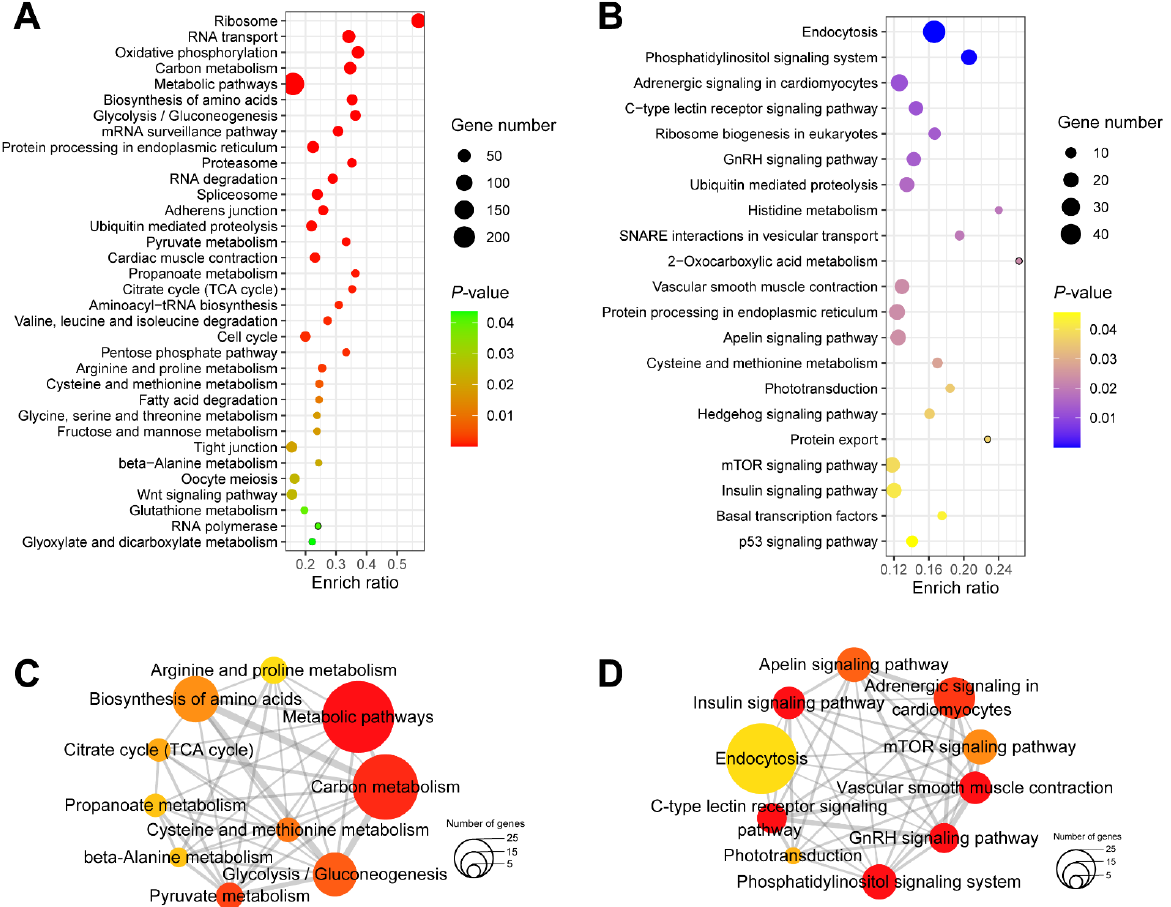
Figure 4. Hub signaling pathways from KEGG enrichment analysis of up- and down-regulated key genes. ( A ) Dot plot of KEGG signaling pathways for up-regulated key genes. ( B ) Dot plot of KEGG signaling pathways of down-regulated key genes. ( C ) Network of top 10 hub pathways for up-regulated key genes. ( D ) Network of top 10 hub pathways for down-regulated key genes. Nodes represent pathways and edges represent Jaccard similarity coefficients. Node color and size stand for the enrichment p -value and the number of genes in the pathway, respectively. Table 2. Top 10 hub pathways of down-regulated genes ranked by the MCC method. Rank Signaling